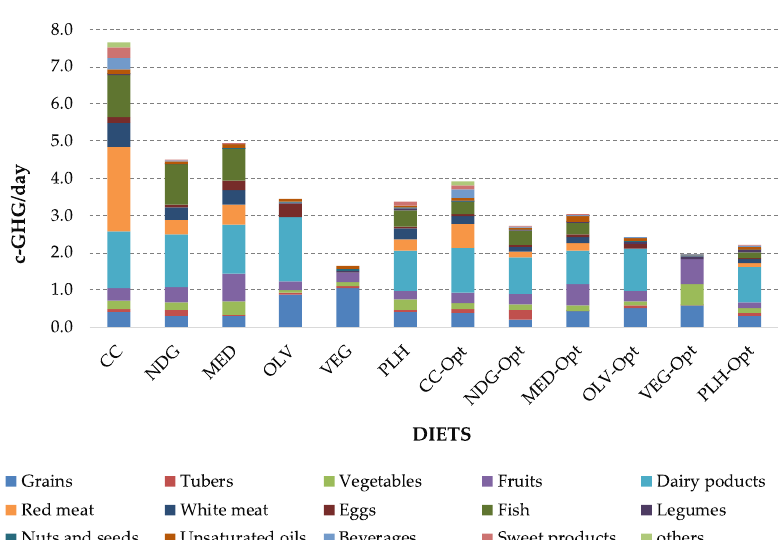
Figure 7. Corrected GHG emissions of all diet scenarios.